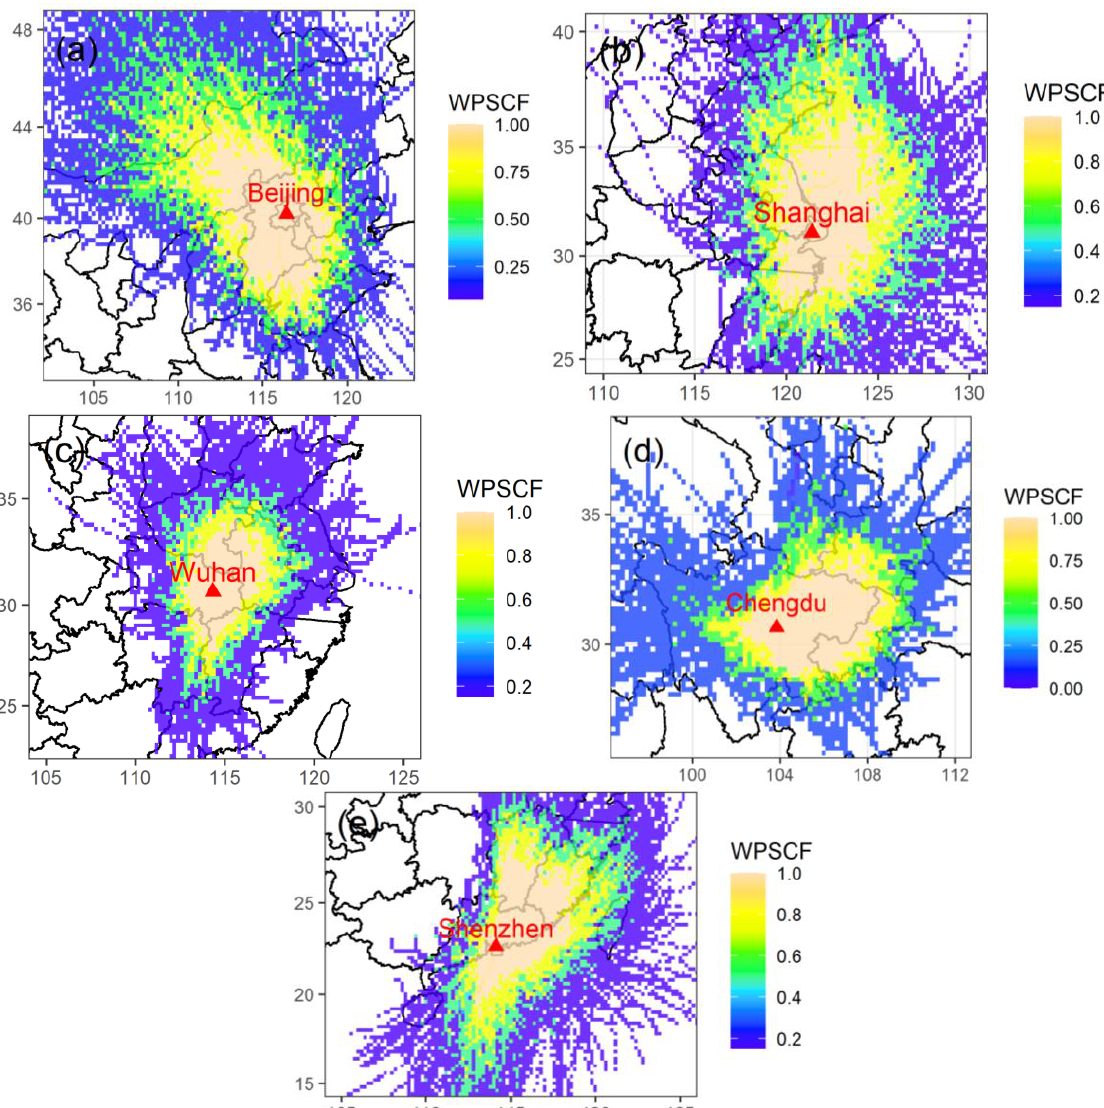
Figure 9. Results of PSCF analysis for MDA8 O 3 in ( a ) Beijing, ( b ) Shanghai, ( c ) Wuhan, ( d ) Chengdu, and ( e ) Shenzhen.